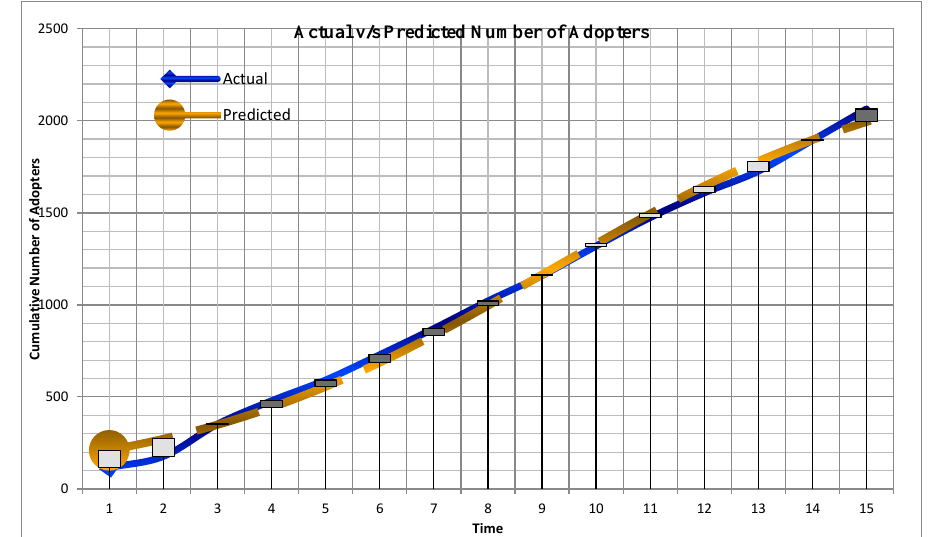
Fig. 2. Actual versus predicted number of adopters